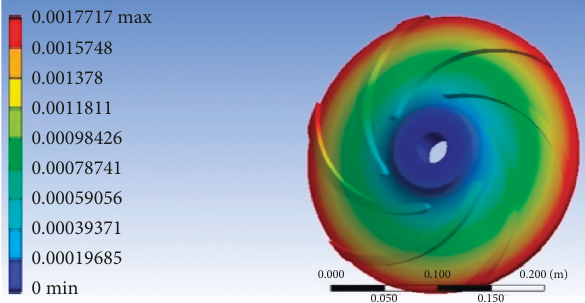
Figure 11: Total displacement deformation cloud map.